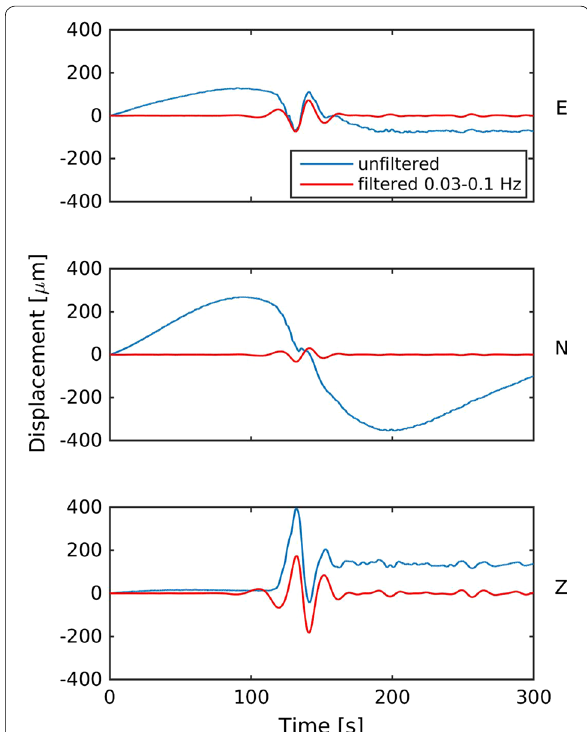
Fig. 6 Unfiltered (blue) and filtered (red) displacement waveforms recorded at station WI04 for the large VLP just prior to eruption P4. The waveforms were band-pass-filtered between 0.03 and 0.1 Hz. Note the very-long-period noise/tilt present on the horizontal components, which makes the recovery of the static shift at these components